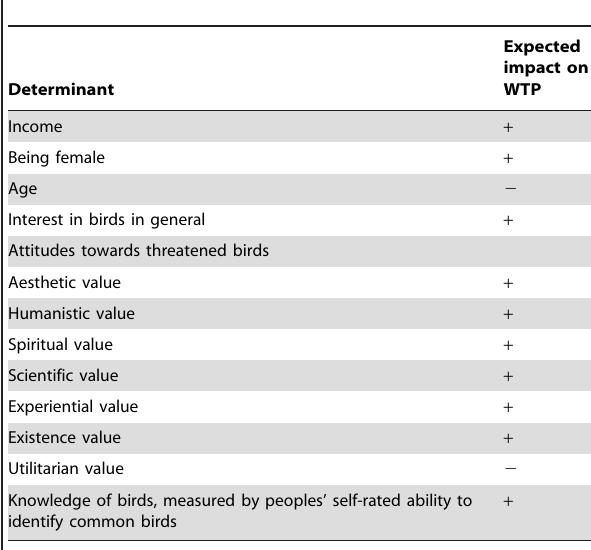
Table 1. Potential willingness-to-pay (WTP) determinants and their expected impact (positive [ + ]/negative [ 2